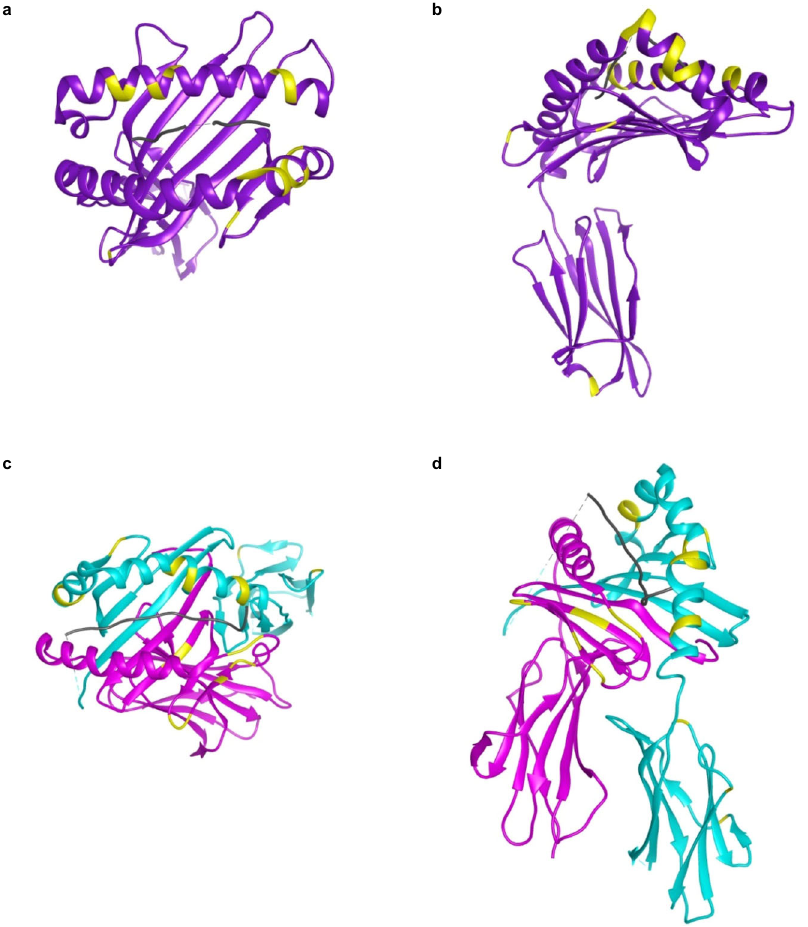
Fig. 1 Class I and class II HLA proteins and their eplets. a Top-down view of the peptide-binding groove of HLA-A*02:01 (without β 2 microglobulin). The HLA-A*02:01 protein is shown in purple, a processed self-peptide in black, and its B-cell eplets highlighted in yellow. b Side-view of HLA-A*02:01, showing the alpha 3 portion and an eplet outside of the peptide-binding groove. c Top-down view of the peptide-binding groove of HLA-DQ. The DQA1*03:01 chain is in fuchsia, DQB1*02:01 is in aqua, a processed peptide in black, and eplets highlighted in yellow. d Side-view of HLA-DQ2.3 showing alpha 2 of the alpha and beta chains with highlighted eplets. Molecular graphics and analyses performed with UCSF Chimera, developed by the Resource for Biocomputing, Visualization, and Informatics at the University of California, San Francisco, with support from NIH P41-GM103311 13 using the Protein Data Bank ID: 4u6x (HLA-A*02:01) 14 and 4d8p (HLA-DQ2.3) 15